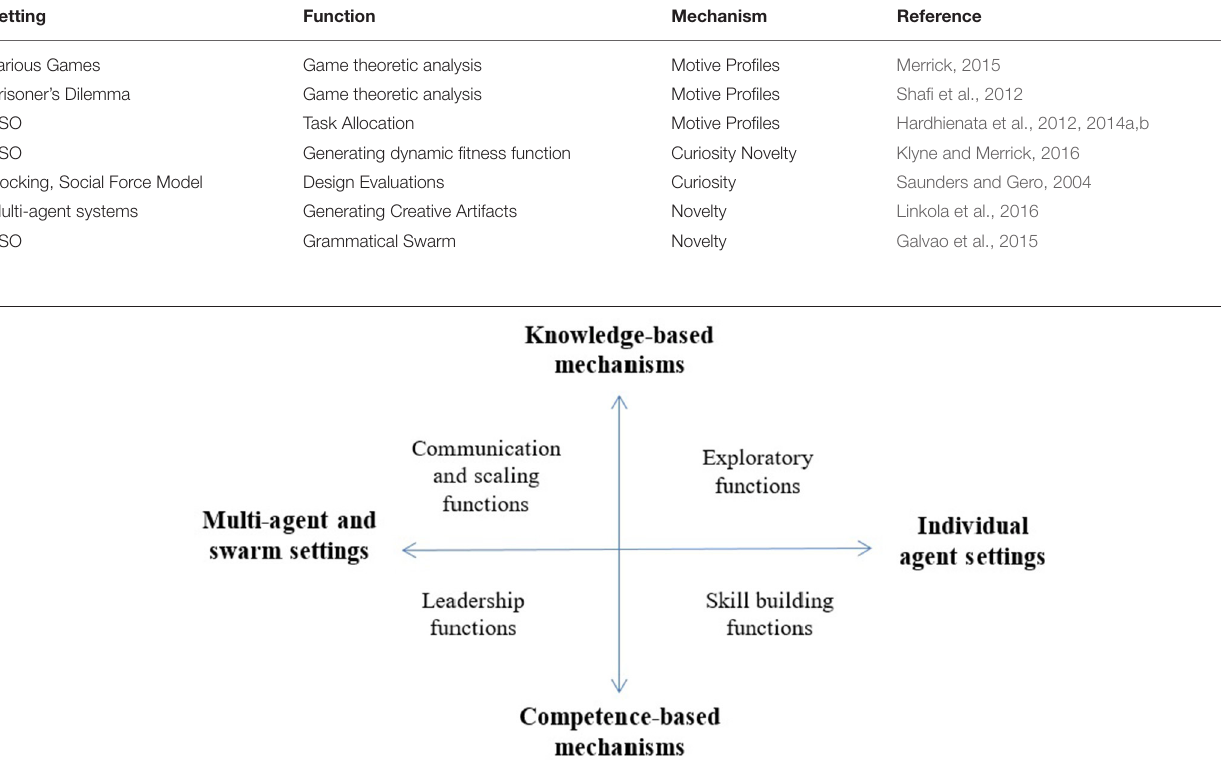
FIGURE 2 | Expanding the view of settings for computational models of motivation also expands possible